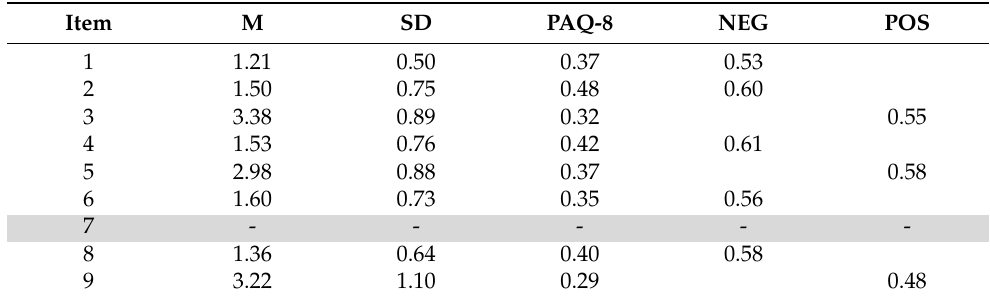
Table 5. Descriptive statistics (means, SD) and corrected item-total scale correlations of Analysis 2 for the